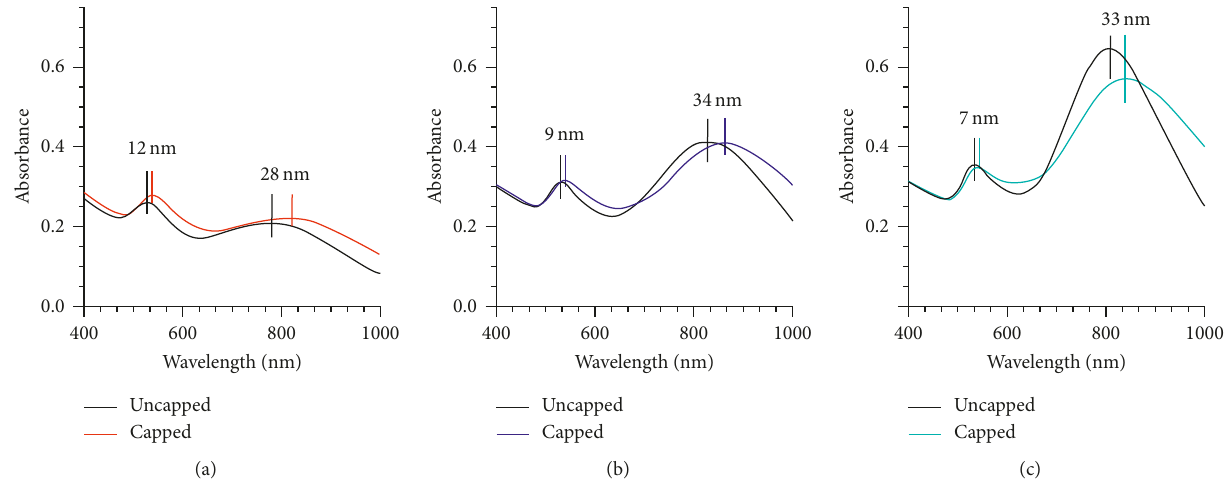
Figure 7: Spectra of samples of AuNPs before and after the addition of chitosan solution for three molar ratios: (a) R and (c) R (cid:30)